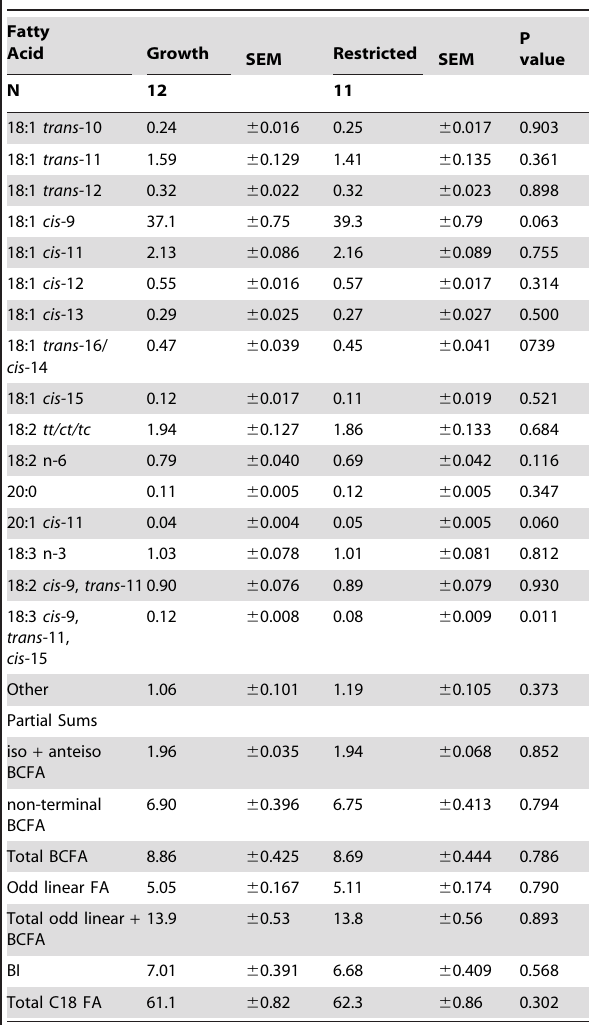
Table 2. Effect of feed restriction in the fatty acid composition (% of total fatty acids) of the fat tail in Damara ram